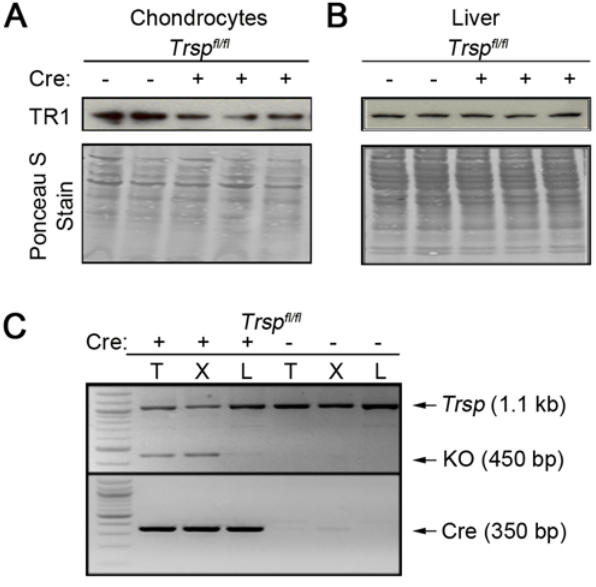
Figure 7. Immunoblotting analysis of TR1 in chondrocytes and demonstration of Trsp excisions in cartilage-rich tissues. Protein extracts were prepared from (A) chondrocytes and (B) liver samples from two control ( Trsp fl/fl ) and three Trsp fl/fl Col2a1-Cre ) mice. Lysates were then subjected to electrophoresis, transblotted, and probed with an anti-TR1 antibody (upper panels) as described in the Materials and Methods section. The lower panels show the Ponceau S-stained membranes of the total protein extracts as loading controls. Representative blots are shown. (C) Representative genotyping results from tail tip, xiphisternal and liver DNA samples from control and experimental mice. PCR reactions to detect Trsp fl/fl 450 bp excision band are shown in the upper panel; and PCR demonstrating the presence of the Col2a1-Cre transgene are in the lower panel.